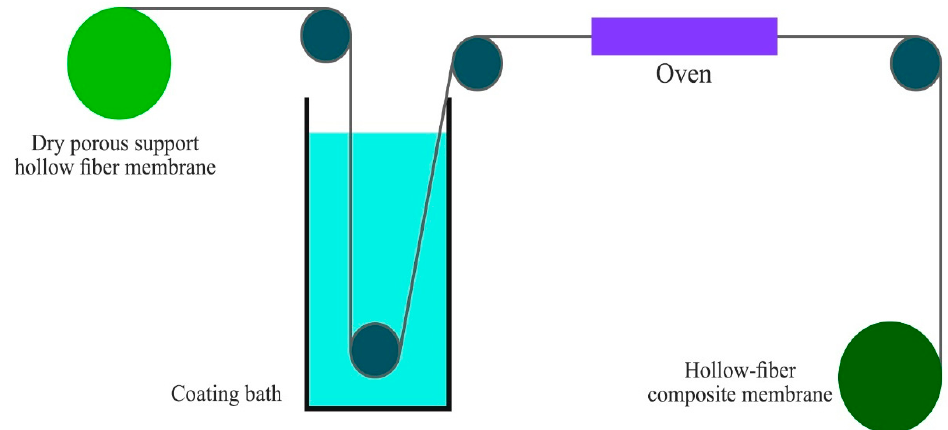
Figure 12. Hollow-fiber composite membrane fabrication by the dip-coating process.